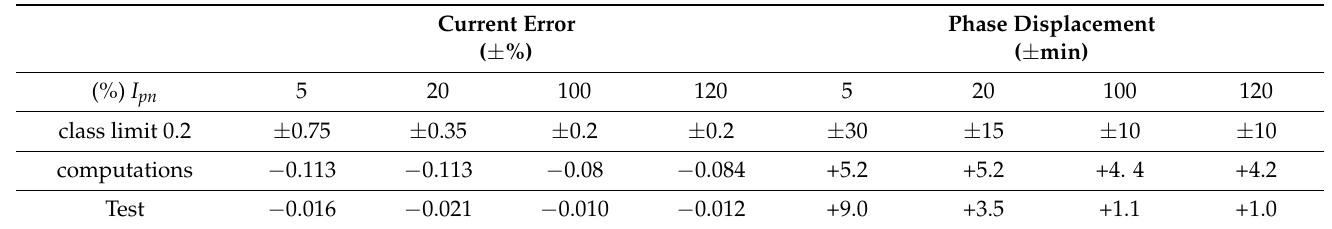
Table 1. The transformation errors of the short-circuit current transformer in accordance with IEC/EN 61869-2.